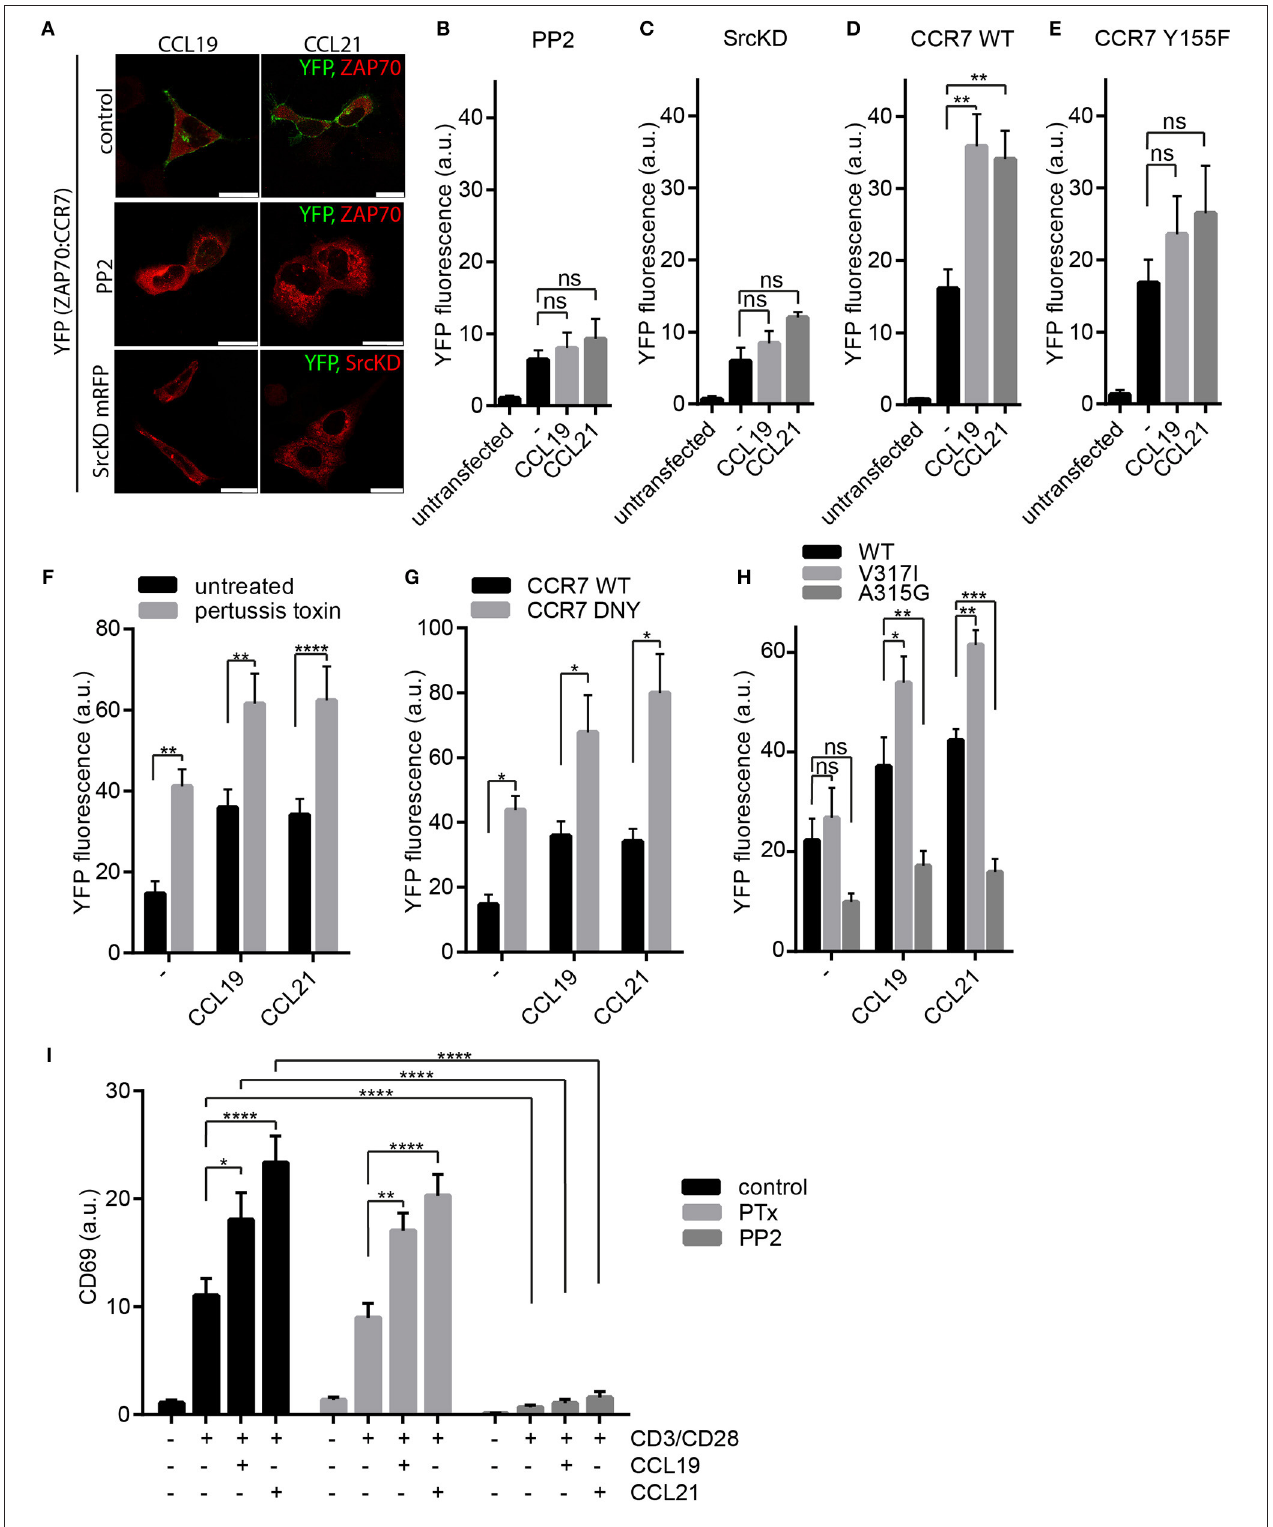
FIGURE 3 | Chemokine-driven ZAP70 recruitment to CCR7 depends on Src. (A) Confocal images of CCR7-YFP2:ZAP70-YFP1 BiFC upon chemokine stimulation (0.5 µ g/ml for 1h) in HEK293 cells that were left untreated or pre-treated with PP2 (10 µ M), or co-transfected with a kinase-dead variant of Src (SrcKD). Representative images derived from one out of three independent experiments; scale bars, 25 µ m. (B,C) Quantification of CCR7-YFP2:ZAP70-YFP1 BiFC assessed